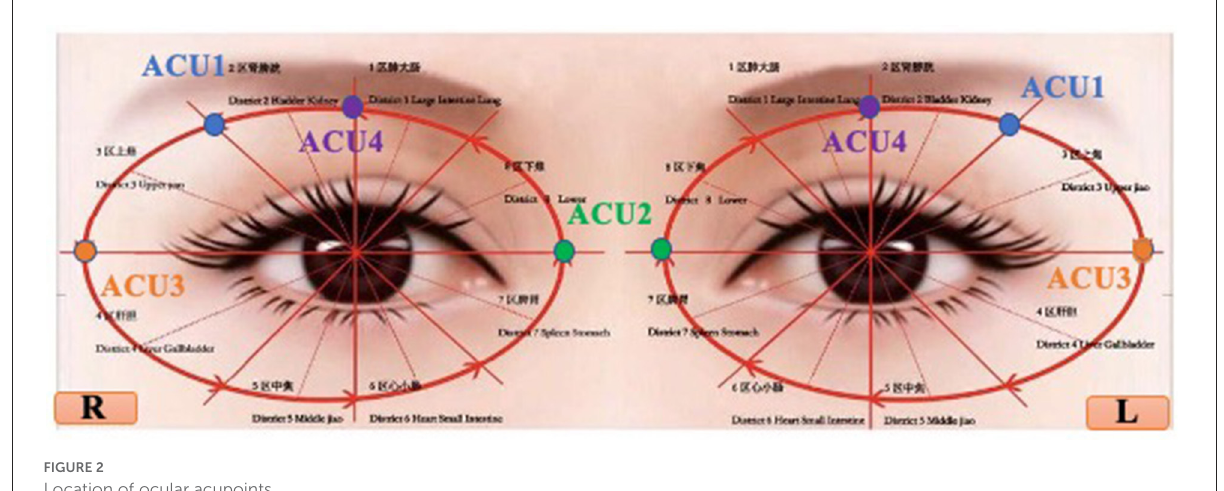
FIGURE2 Location of ocular